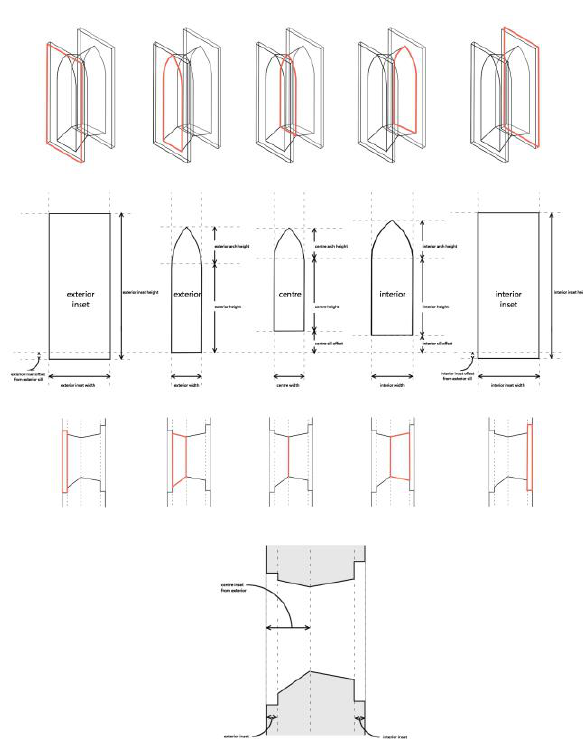
Figure 4. Diagrams representing the series of parametric objects controlled in both section and elevation.